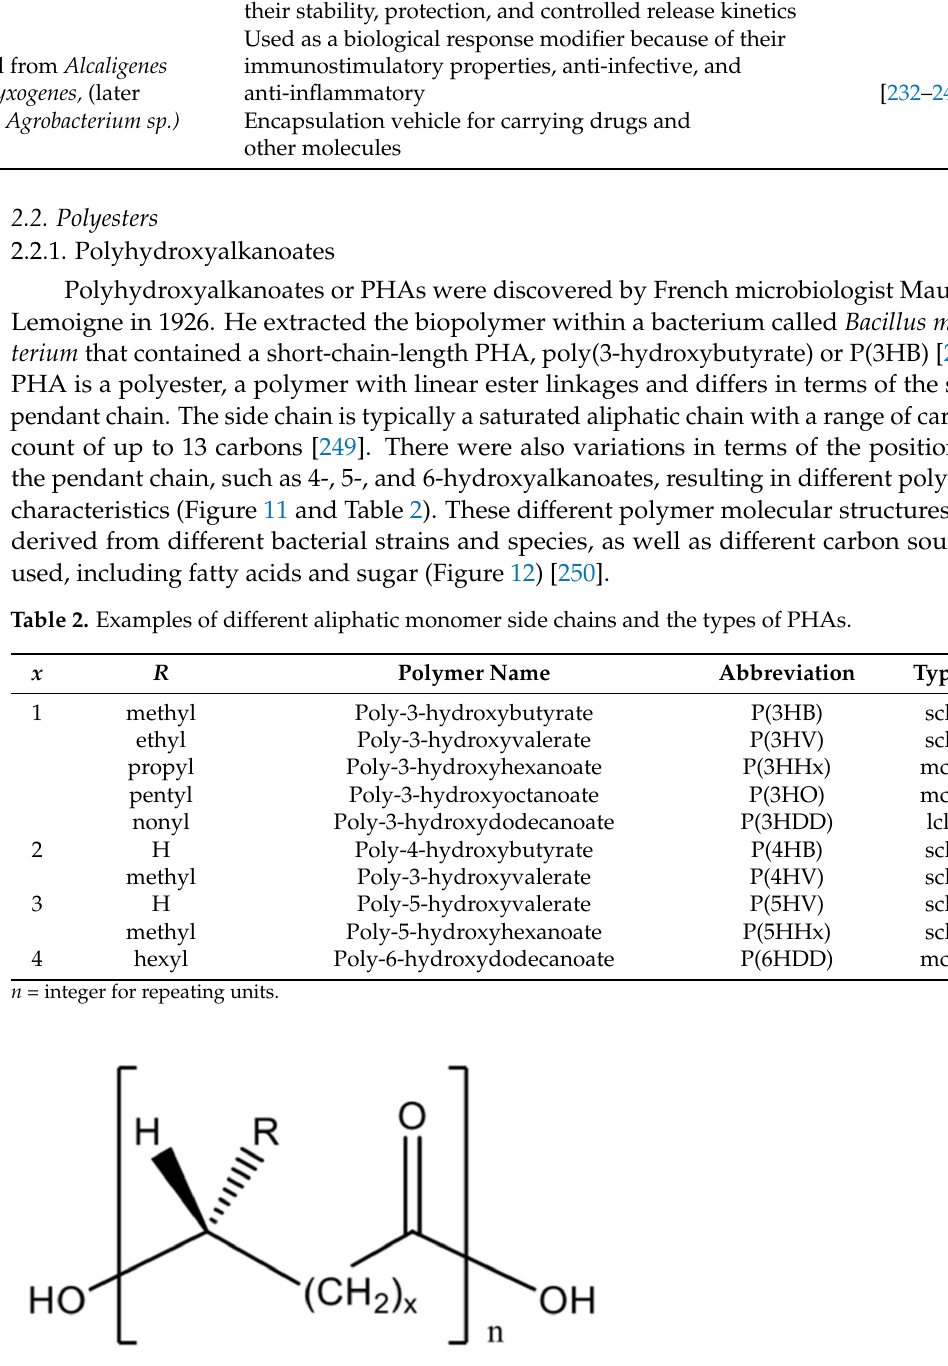
Figure 11. The general chemical structure of